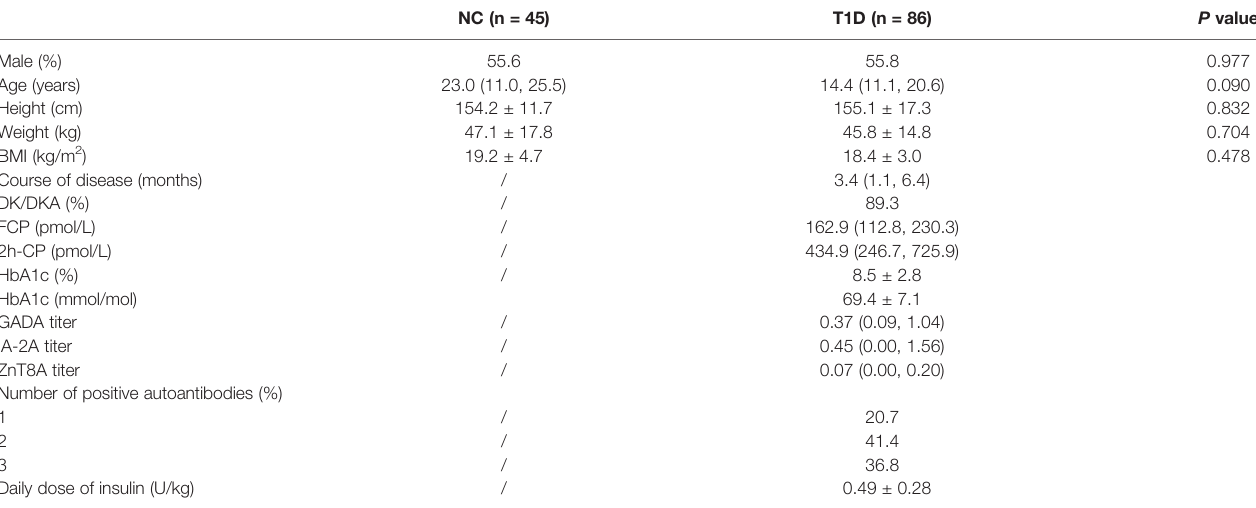
TABLE 1 | The clinical characteristics of T1D patients and NC